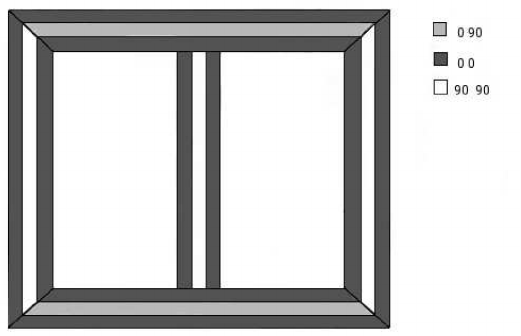
Figure 15. Thin-walled two-cell beam cross section.